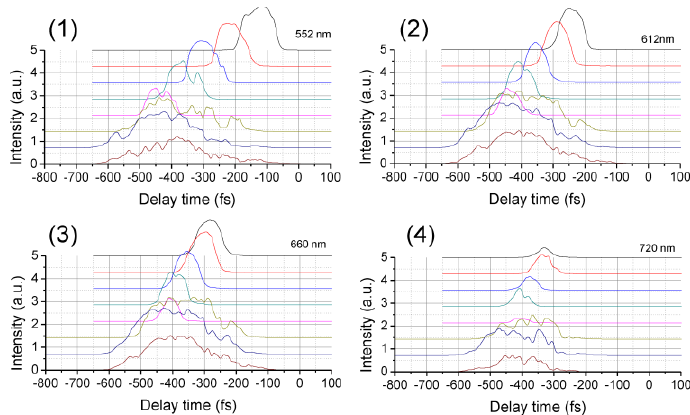
Figure 5. (Color online) Amplified signal intensity as a function of pump-signal delay at four wavelengths. In each figure, the curves from top to bottom are respectively taken from Figures 2a – h.